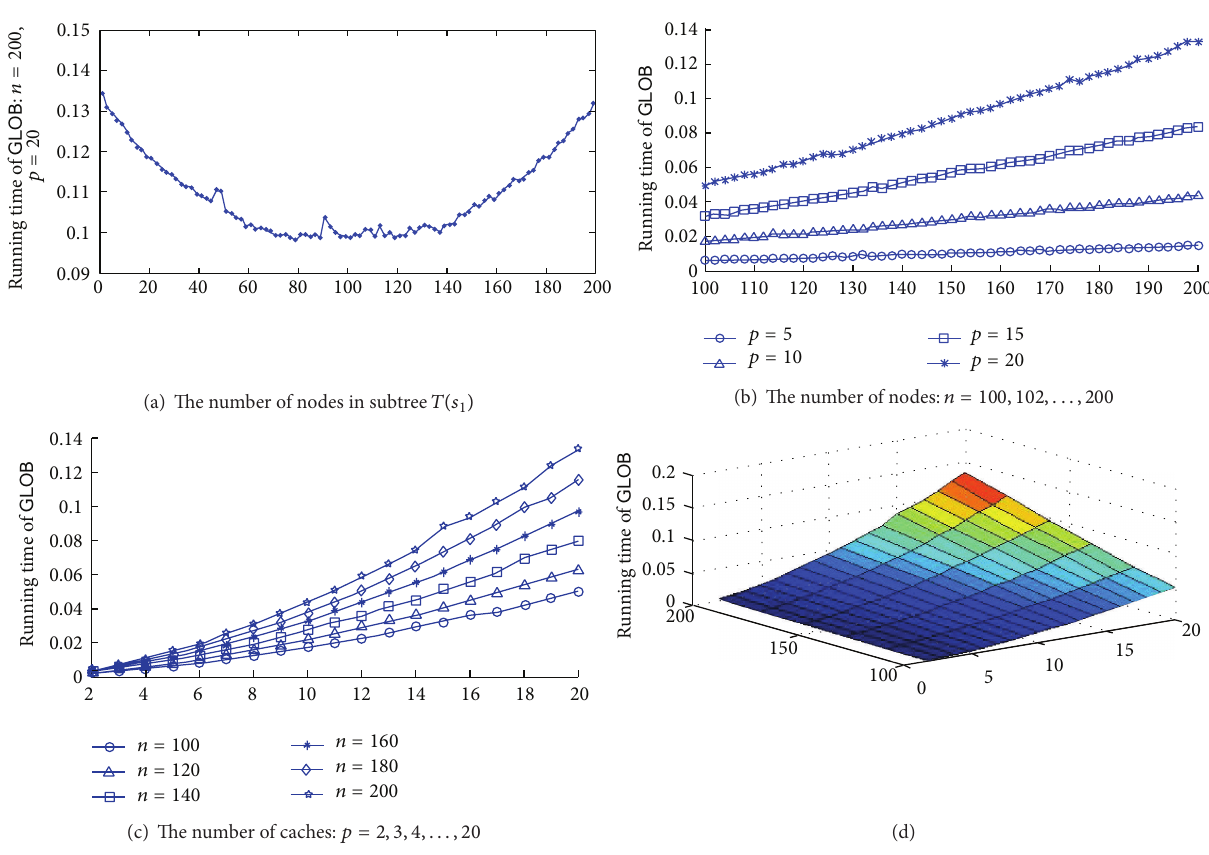
Figure 4: Compare the running times of GLOB for 𝑛 = 100, 102, 104, .. ., 200 and 2 ≤ 𝑝 ≤ 20